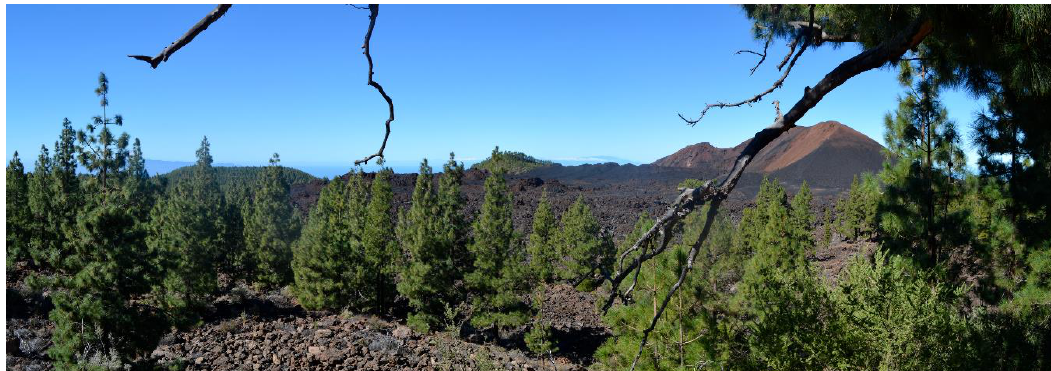
Figure 8. Different volcanic features and landforms of the Chinyero Nature Reserve. Figure 8. Di ff erent volcanic features and landforms of the Chinyero Nature